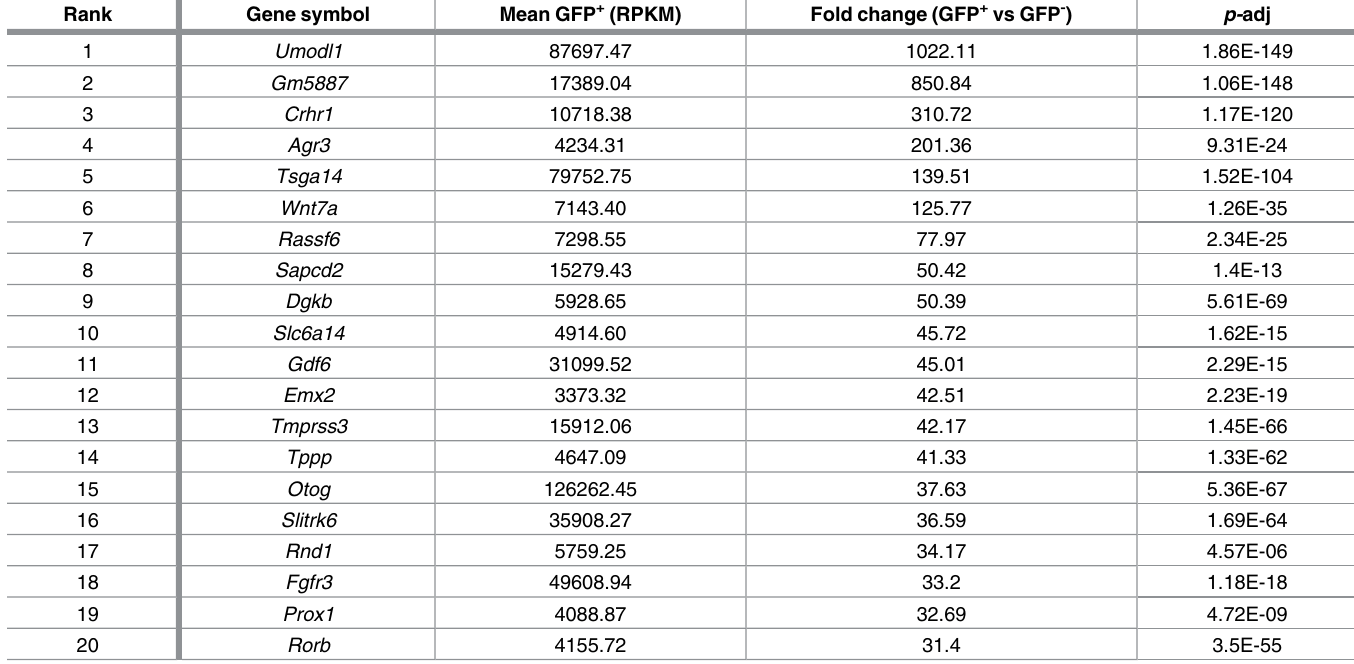
Table 2. Top 20 genes enriched in Lfng-GFP + cells at P6.